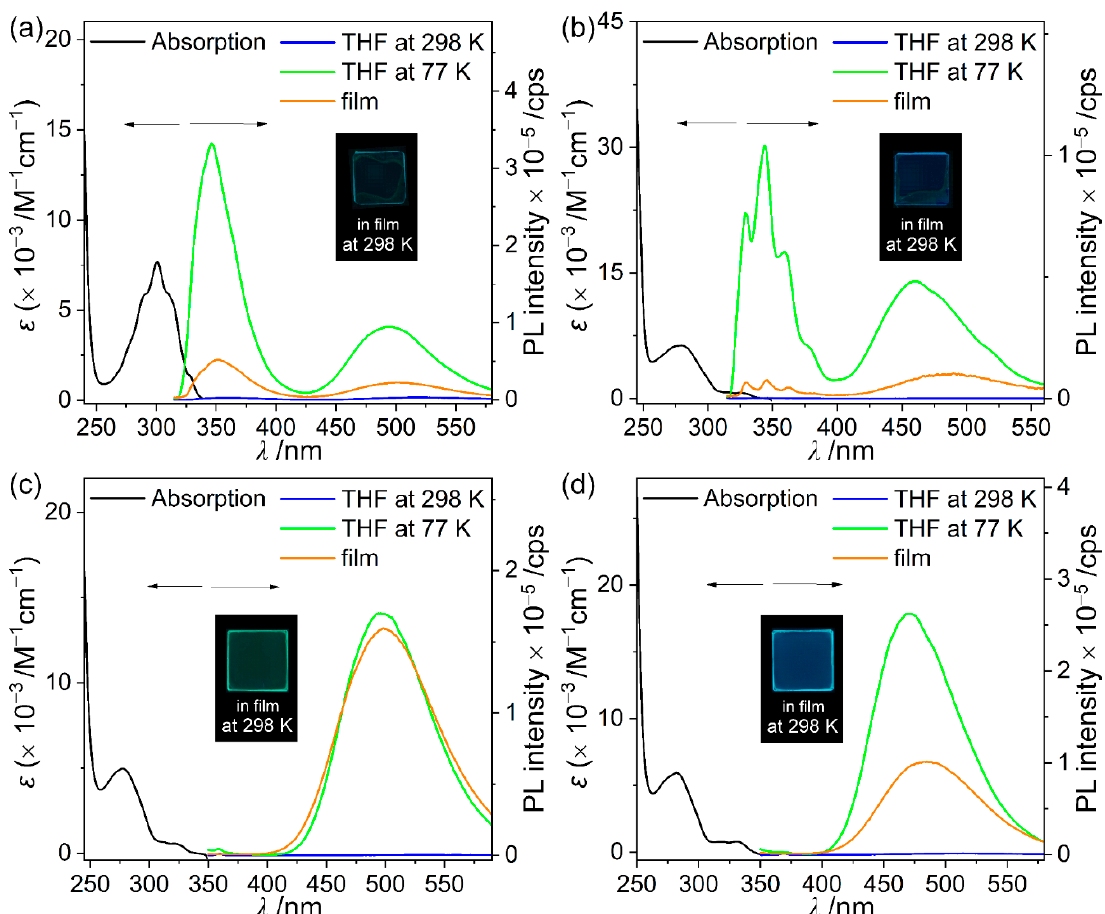
Figure 2. UV-vis absorption (left side) and PL spectra (right side) for (a) 15CH ( λ ex = 305 nm), (b) 26CH ( λ ex = 285 nm), (c) 15CS ( λ ex = 329 nm), and (d) 26CS ( λ ex = 333 nm). Black line: absorption spectra in THF (50 µM), blue line: PL spectra in THF (50 µM) at 298 K, green line: PL spectra in THF (50 µM) at 77 K, and orange line: PL spectra in film (5 wt% doped with PMMA) at 298 K. Inset figures show the emission color in the film state under irradiation by a hand-held UV lamp ( λ ex = 365 nm).